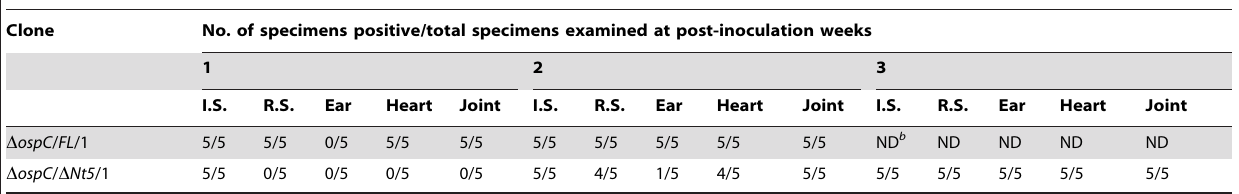
Table 5. The 5-AA deletion affects the ability of B. burgdorferi to disseminate to remote tissues in immunodeficient mice a .